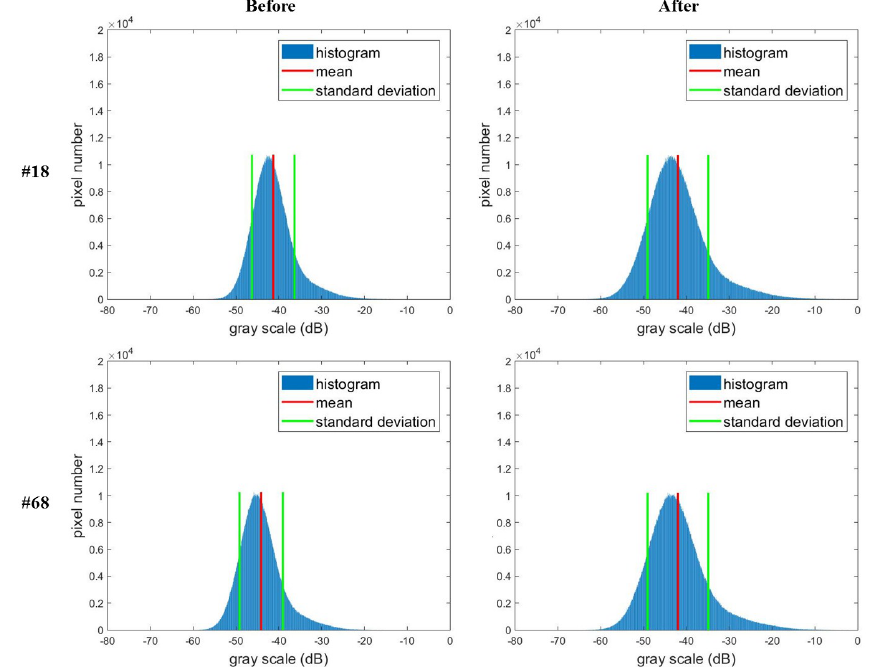
Figure 12. The histograms of 18th and 68th image before and after applying intensity